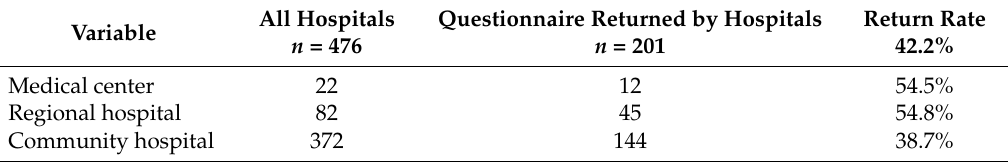
Table 1. Hospital level of national health insurance (NHI) program ( n =